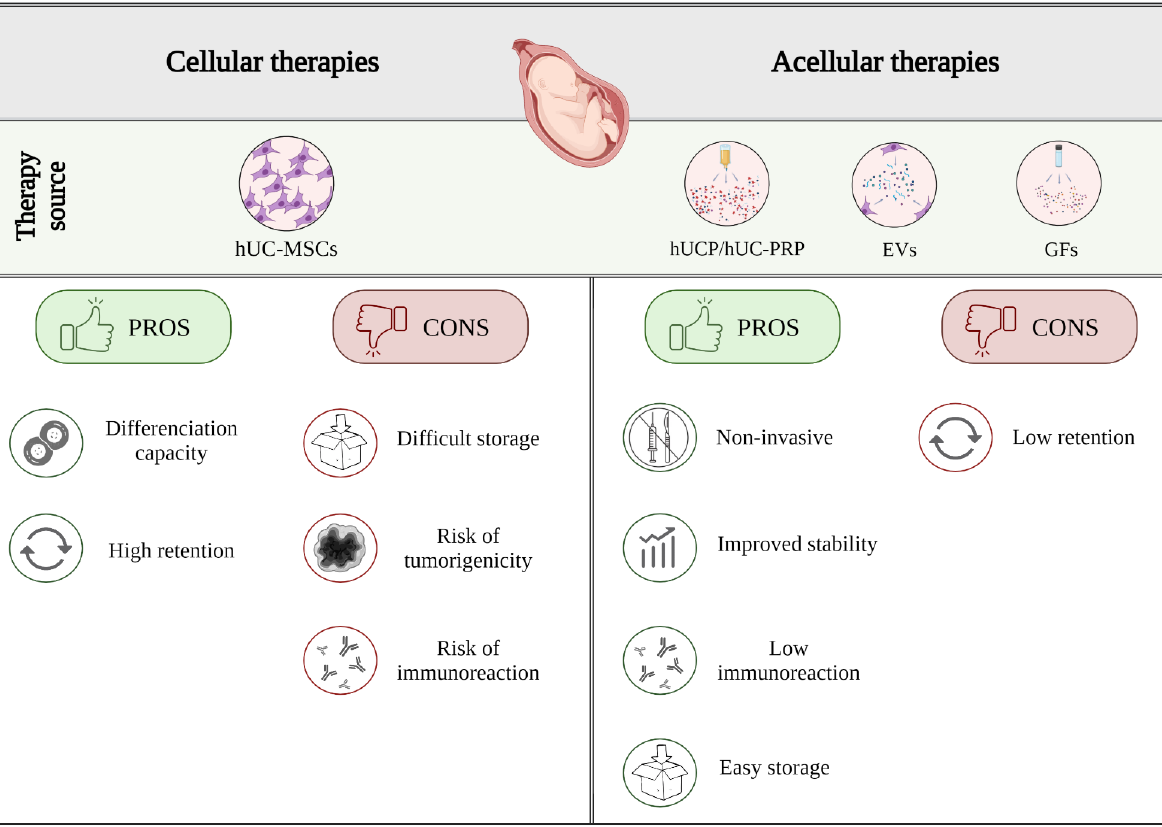
Figure 2. Pros and cons of using cellular and acellular UC therapies in the female reproductive tract. hUC-MSCs: human umbilical cord mesenchymal stem cells; hUCP: human umbilical cord plasma; hUC-PRP: human umbilical cord platelet-rich plasma; EVs: extracellular vesicles; GFs: growth factors.